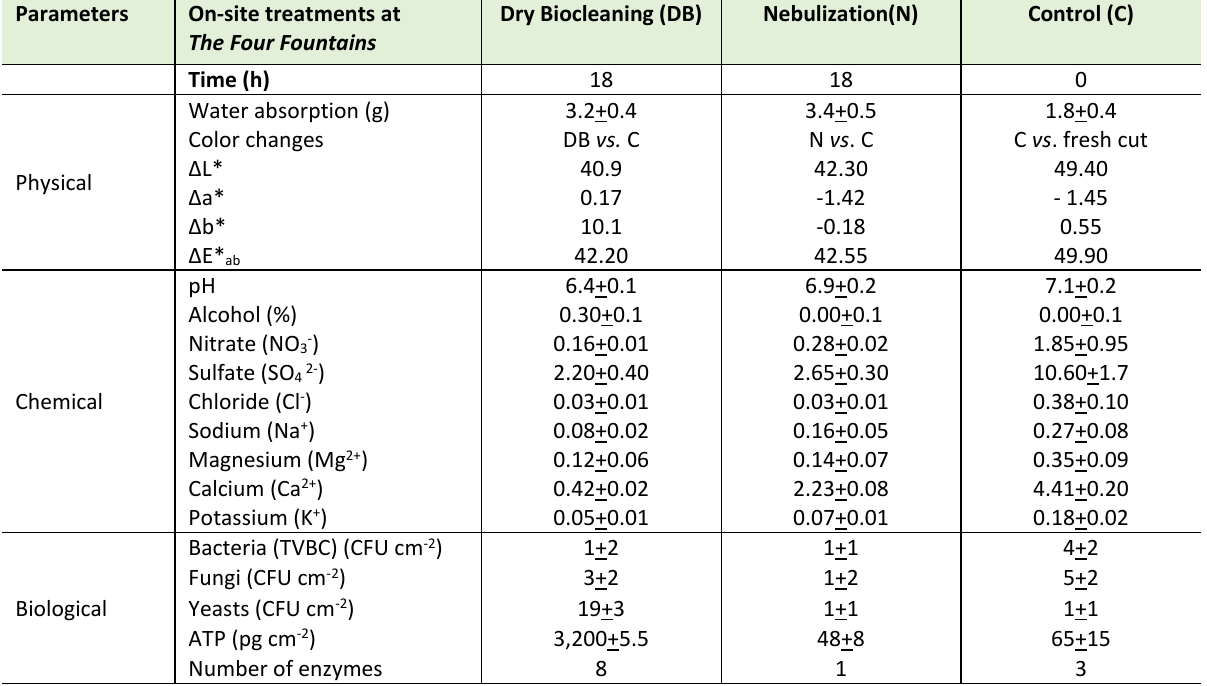
TABLE 2. On-site physical-chemical and biological characterization on The Four Fountains surface after the dry biocleaning process (DB), compared to mechanical treatment by nebulization (N) and untreated control (C). The amounts of nitrate, sulfate, chloride, sodium, magnesium, calcium and potassium ions determined by IC analyses are reported in % w/w (three replicates, mean +